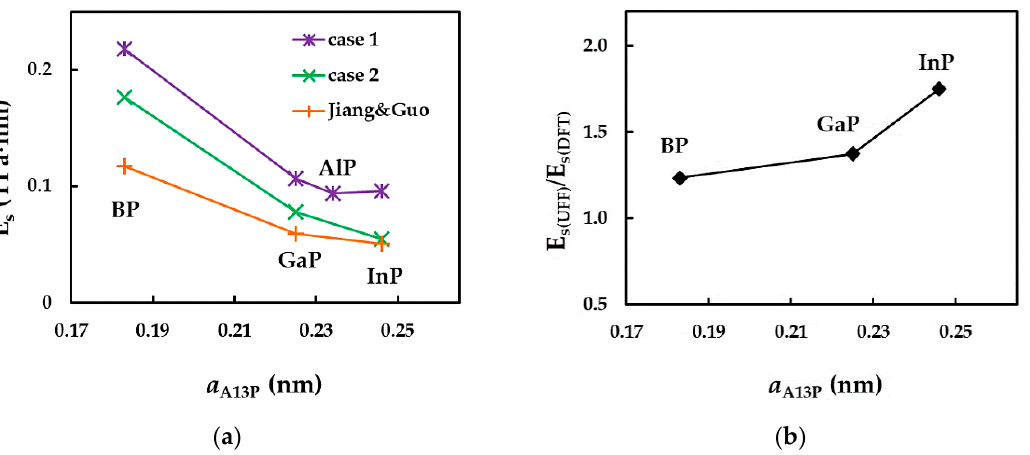
Figure 14. Evolutions of the: ( a ) surface Young’s modulus, E s , for the two cases of input parameters, calculated in the present study, and evaluated by Jiang and Guo [27], and ( b ) ratio of the surface Young’s moduli, obtained for case 1 and 2, E s ( UFF ) /E s ( DFT ) , as a function of the bond length, a A13 − P